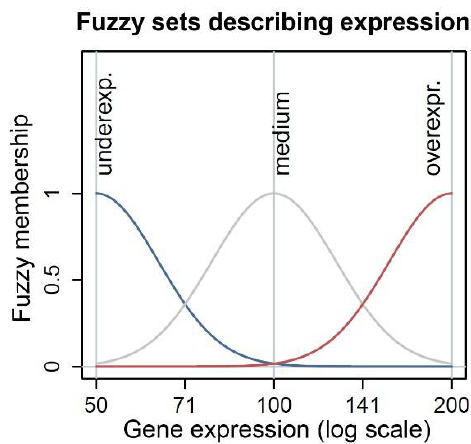
Figure 1. Three fuzzy sets cover the domain of gene expression, thus describing underexpression for low values, medium for the mean expression of the gene, overexpression for high values.